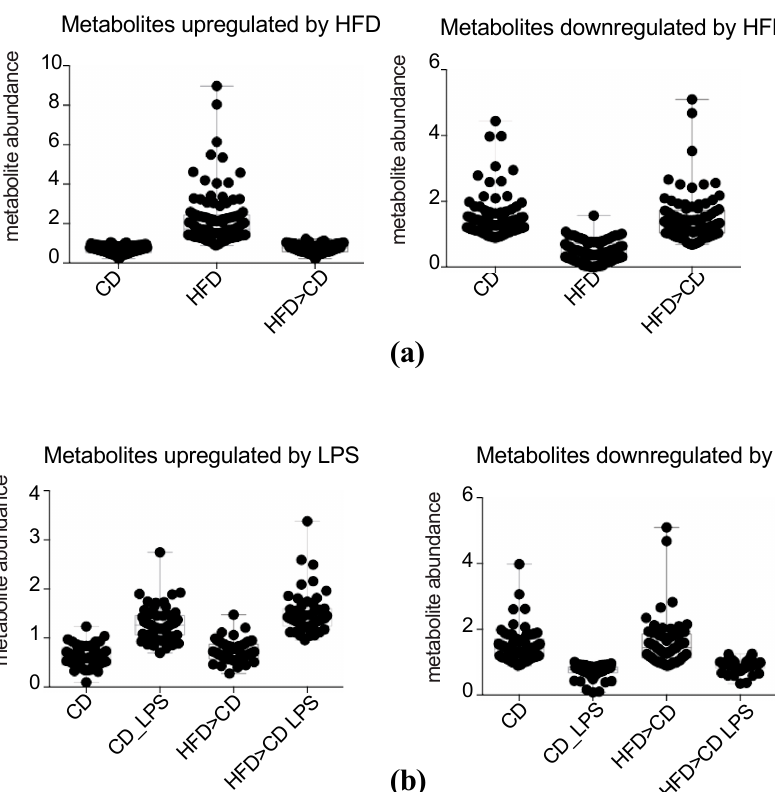
Figure 4. The effects of LPS exposure and HFD feeding on systemic metabolism are not of a long-lasting nature. ( a ) Abundances of metabolites upregulated in the CD-, the HFD- or the HFD > CD-fed groups. Means of individual metabolites are presented; ( b ) Abundances of metabolites upregulated by LPS challenge in the CD-fed group (CD_LPS) and the HFD > CD-fed group (HFD > CD_LPS). Means of individual metabolites are presented.